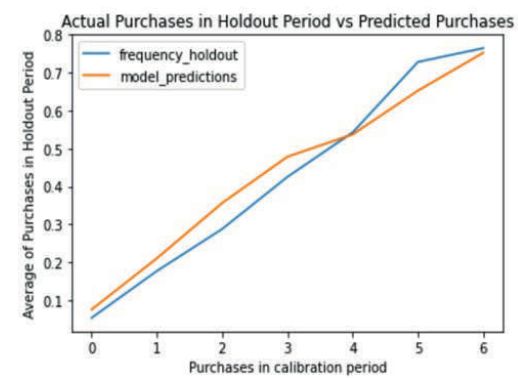
Fig. 4. Frequency recency matrix.